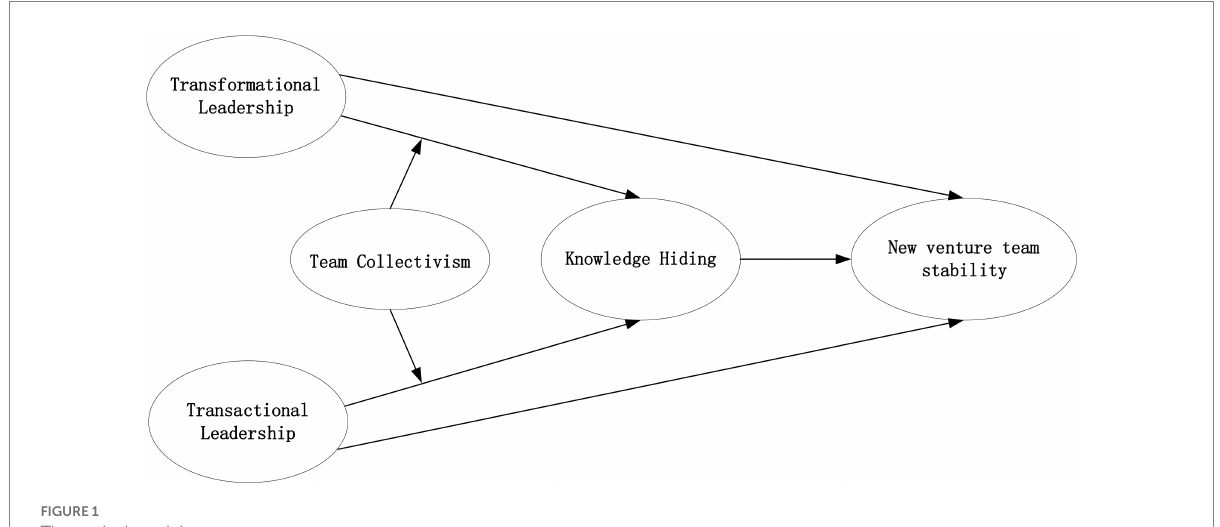
FIGURE 1 Theoretical